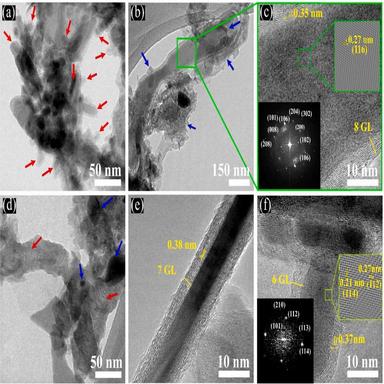
Cristina L. Rodríguez-Corvera et al. TEM and HRTEM images of T1 = 230 ◦C. (a) Sample at low magnification, conformed by various nanostructures embedded in a carbonaceous matrix. (b) Iron sulfide nanoparticles encapsulated in a graphitic material. (c) Close-up to pyrrhotite nanoparticle covered by few graphene layers (~8) and electron diffraction patterns indexed to pyrrhotite crystal (Fe7S8) with an interlayer distance of 0.27 nm for the plane (116) using the crystallographic card 00–024-0220. (d) Carbon fi